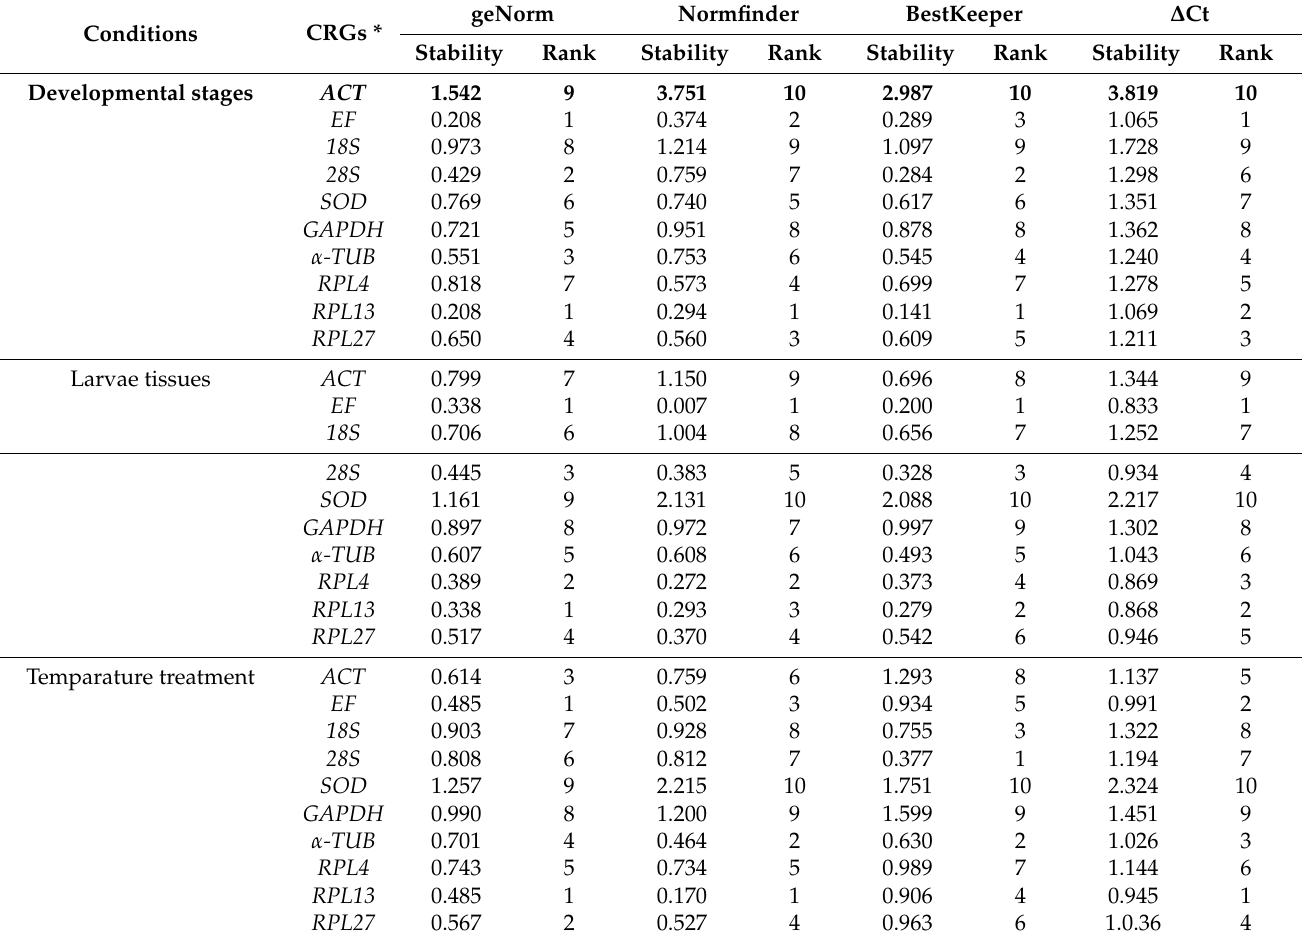
Table 3. Expression stability of the candidate reference genes under different experimental